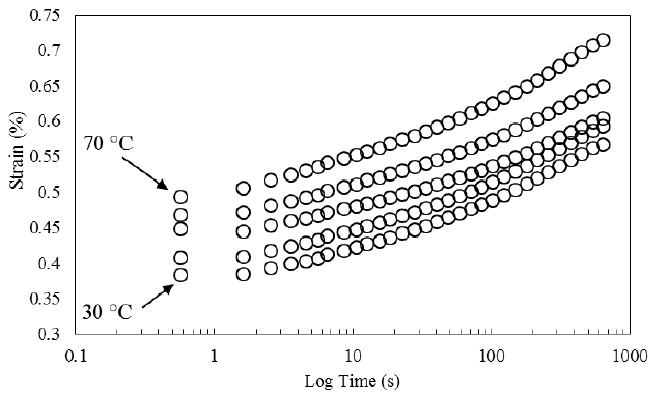
Figure 10. Creep strain vs. time at different temperatures.